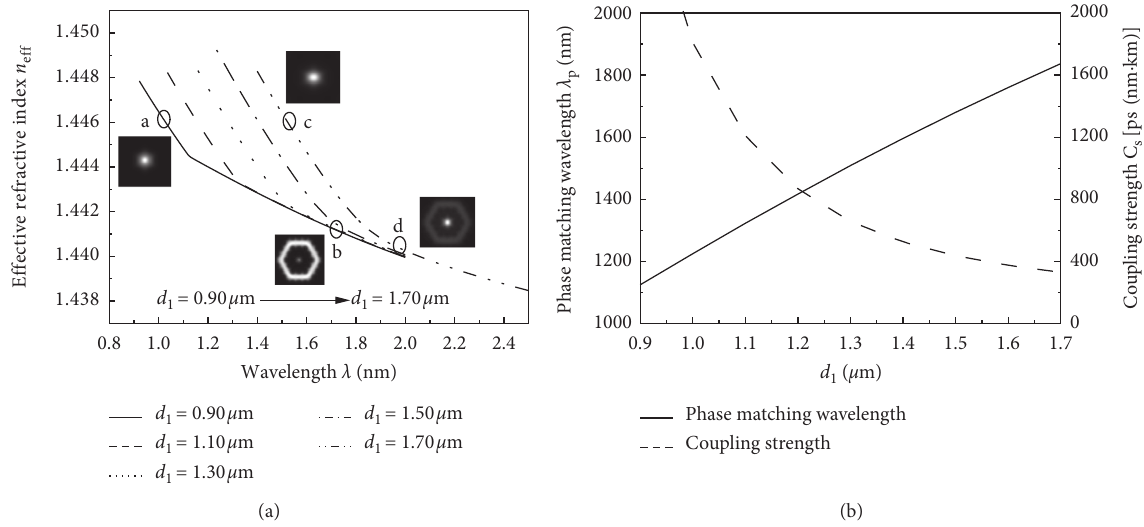
Figure 4: Variation of the effective refractive index of the fundamental supermodel with wavelength when d1 is changed (a) and λp and the coupling strength with d 1 (b). Insets show the modal field distributions of fundamental supermodel at different wavelengths for d 1 � 0.90 μ m and d 1 � 1.70 μ